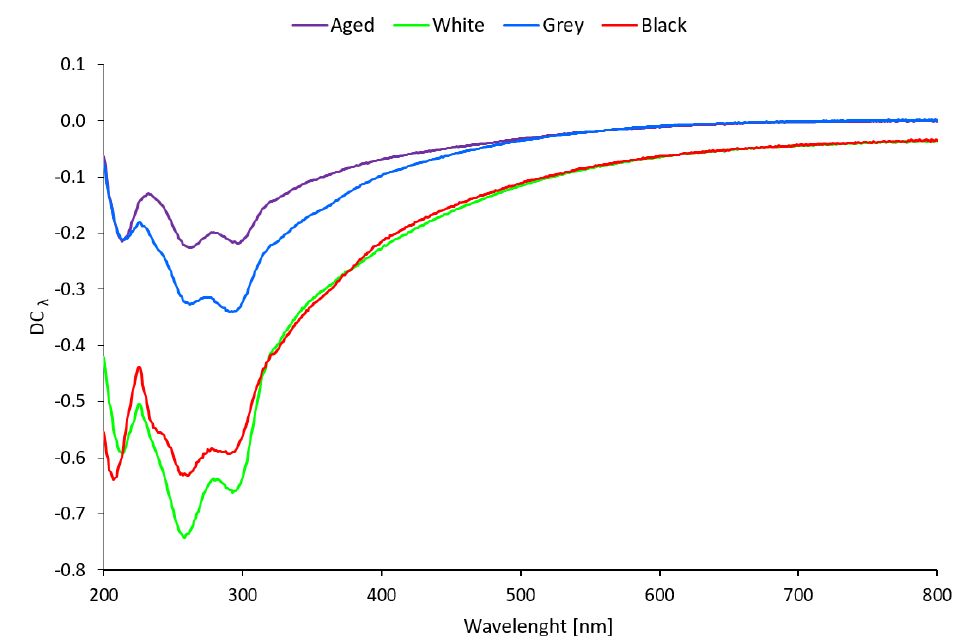
Figure 10. Decoloration curves for Whatman Grade 1 paper aged separately (Aged) and sandwiched in PE foam.